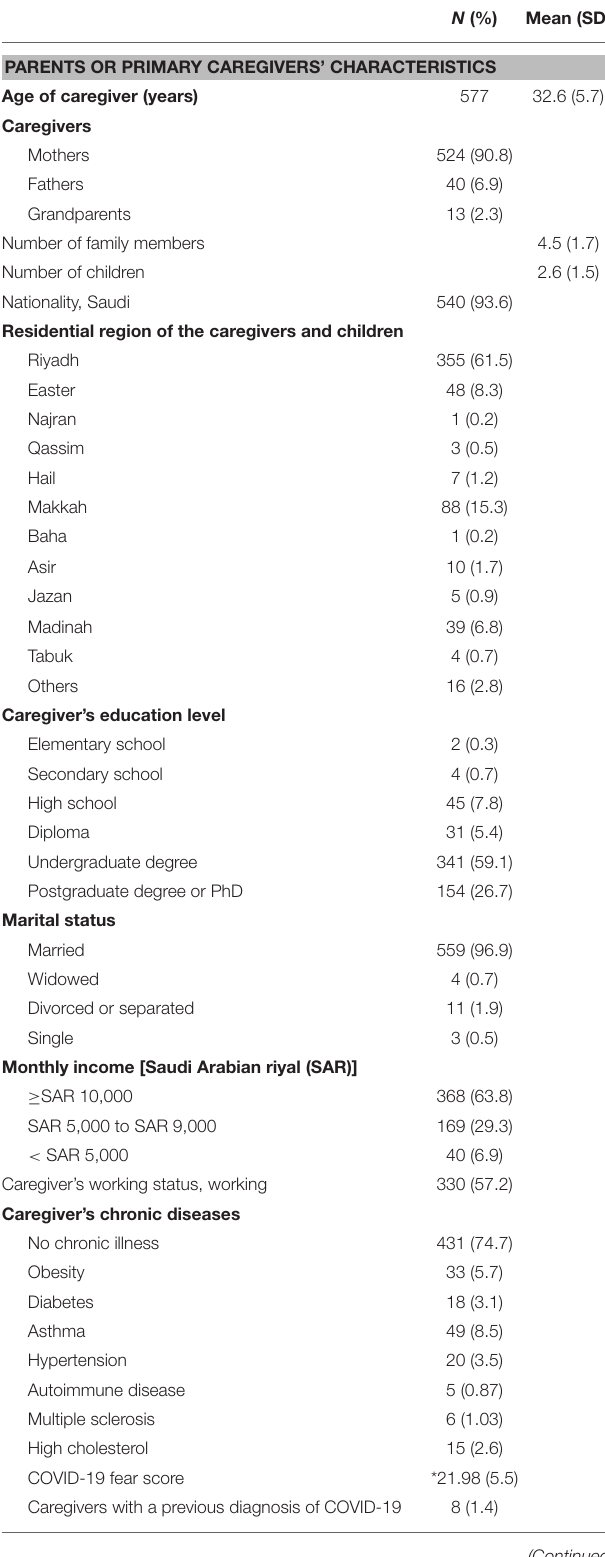
TABLE 1 | Characteristics of the parents or primary caregivers, children, and their health